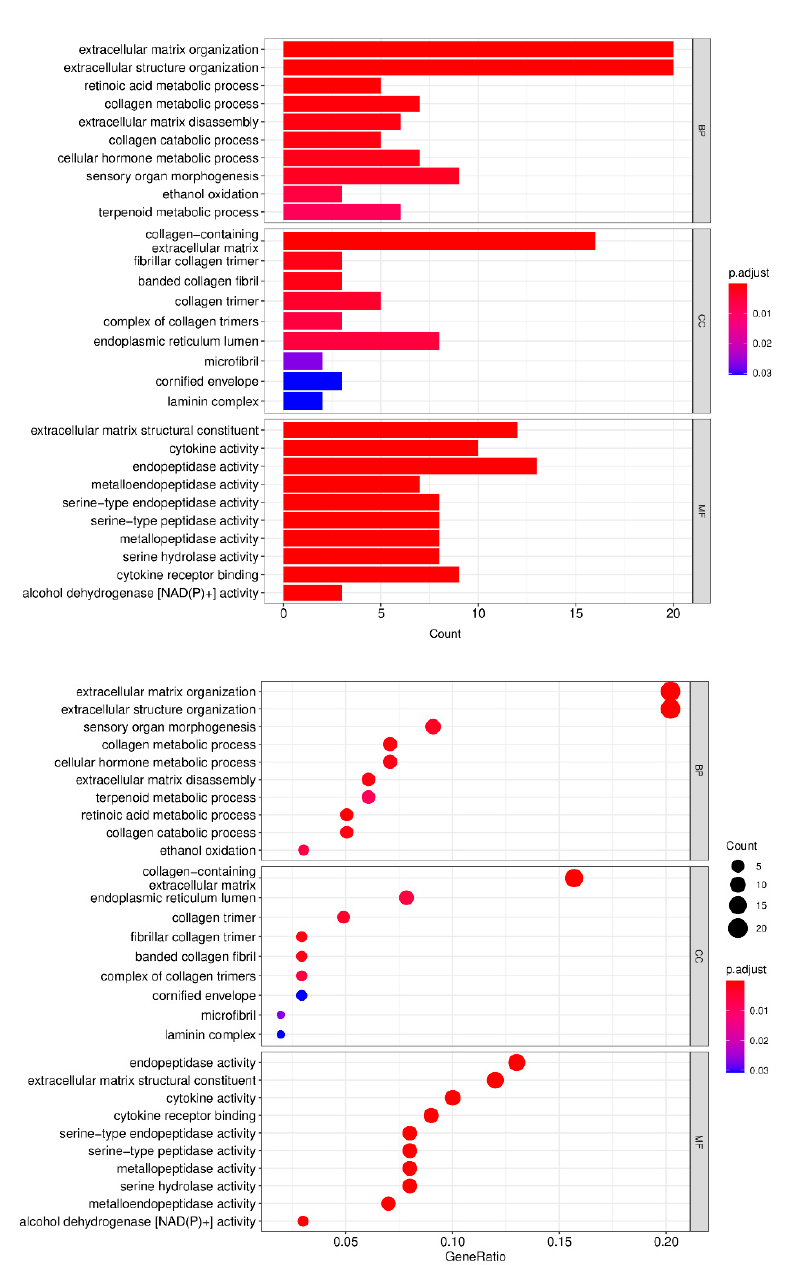
Figure 3. Gene ontology categories. BP: biological process, CC: cellular component, MF: molecular function.